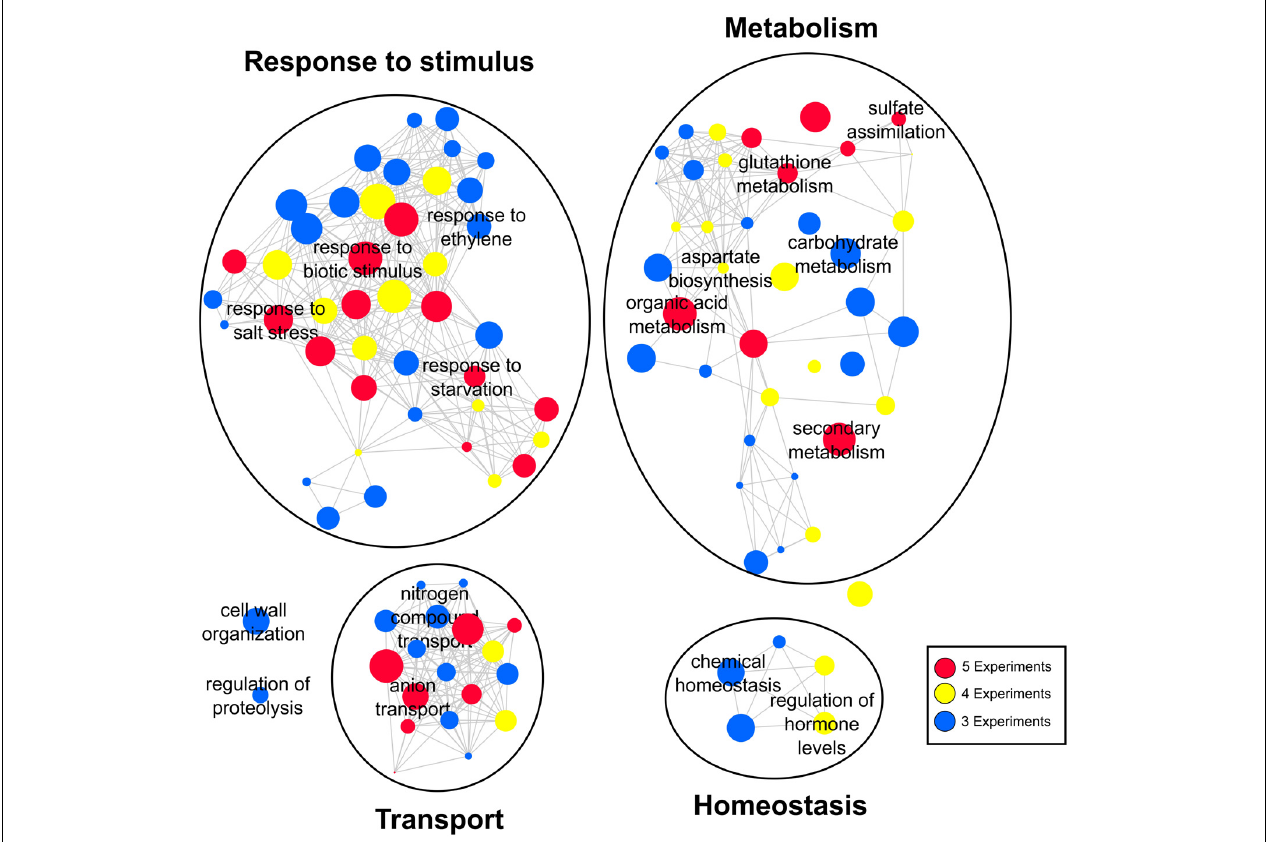
FIGURE 3 | Gene ontology (GO) network of the most frequent biological functions regulated by sulfate. GO terms are linked by edges in the graph according to their semantic similarity (Supek et al., 2011). The bubble size indicates the percentage of genes associated with the corresponding GO term, and the color indicates the degree of consistency of the corresponding GO